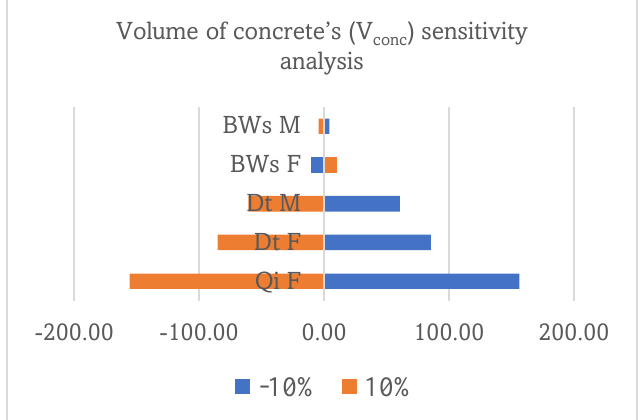
Fig. 4. Volume of concrete’s (V conc ) sensitivity analysis